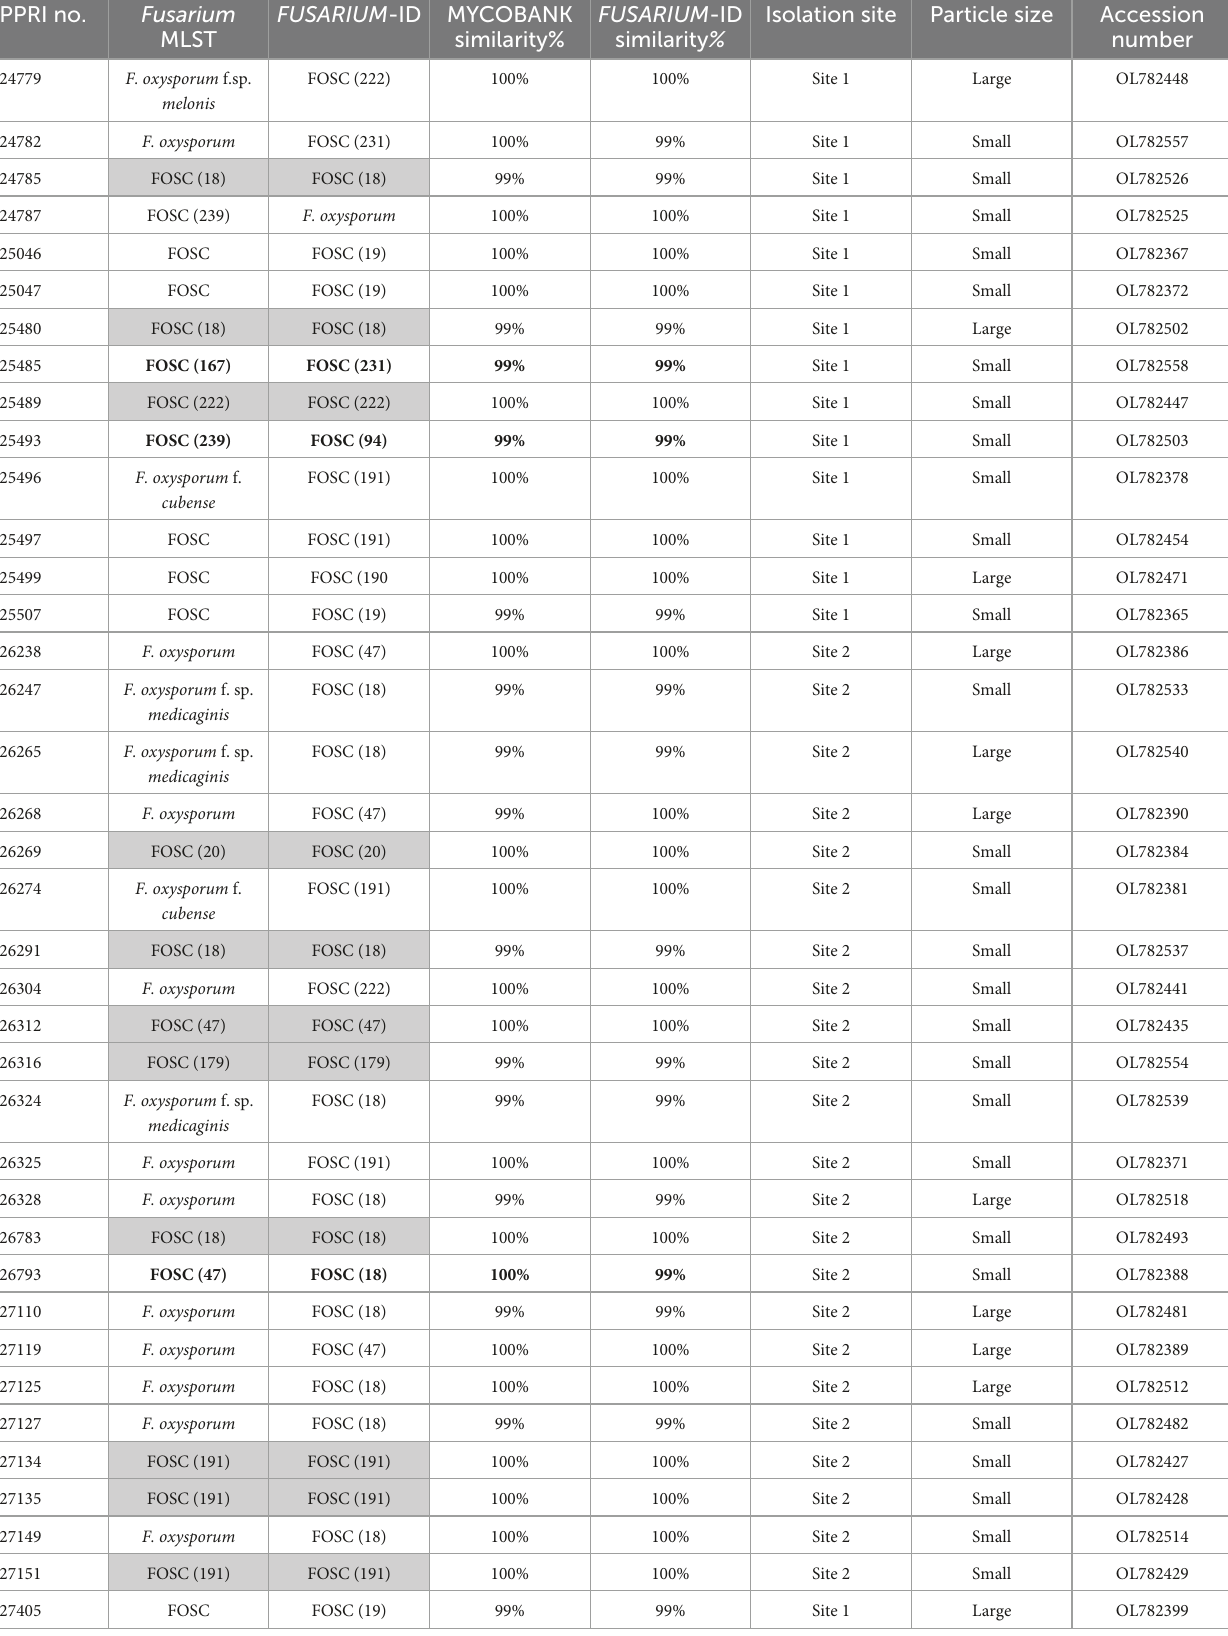
TABLE 2 Nucleotide BLAST (nBLAST TM ) results from the Fusarium MLST and FUSARIUM -ID databases for the FOSC. PPRI